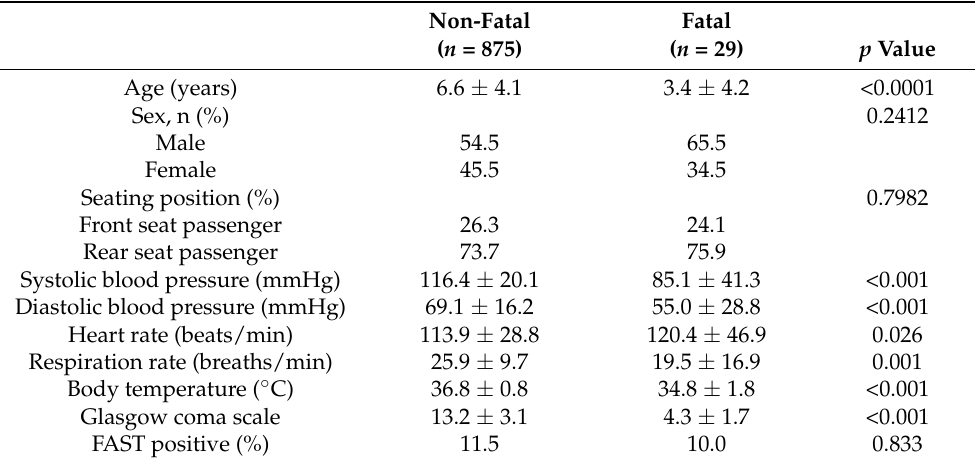
Table 1. Comparison of patients’ characteristics and data at hospital arrival between those aged < 15 years in the fatal and non-fatal groups (2004–2019). FAST: Focused Assessment with Sonography for Trauma.